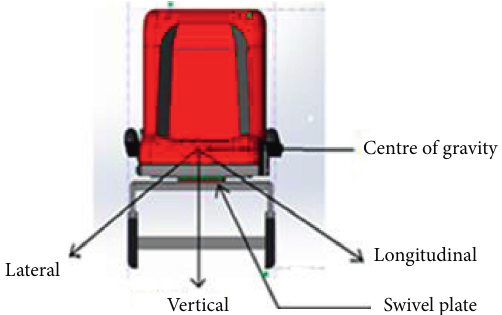
Figure 1: Revolving car seat model.